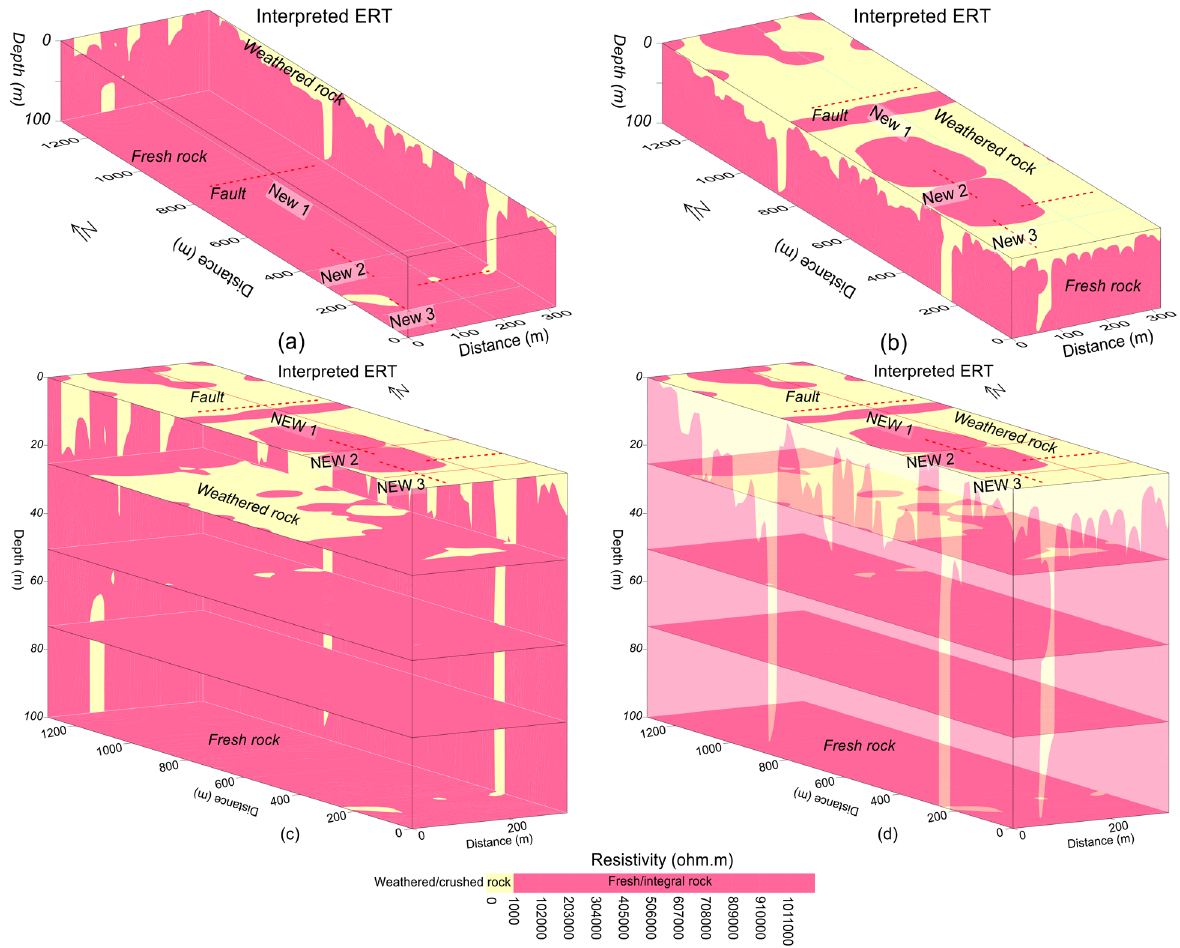
Figure 8. Resistivity imaging along three profiles (red lines) interpreted by the crushed/weathered rock (yellow color) and the integral/fresh rock (red color) and the faults (dashed red lines) for: ( a ) inner view of 3D ERT, ( b ) outer view of 3D ERT, ( c ) different depths including 3D ERT (inner view), ( d ) the outer view of 3D ERT with different